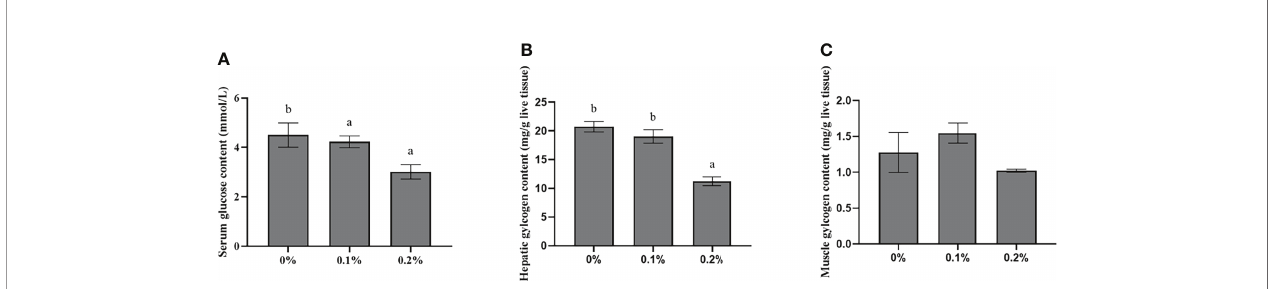
FIGURE 1 | Effects of dietary nano-curcumin on serum glucose (A) , liver glycogen (B) , and muscle glycogen (C) in largemouth bass. Values (mean ± standard error of the mean, SEM) in bars that have the same letter are not signi fi cantly different (P > 0.05; Duncan ’ s test) between treatments (N =